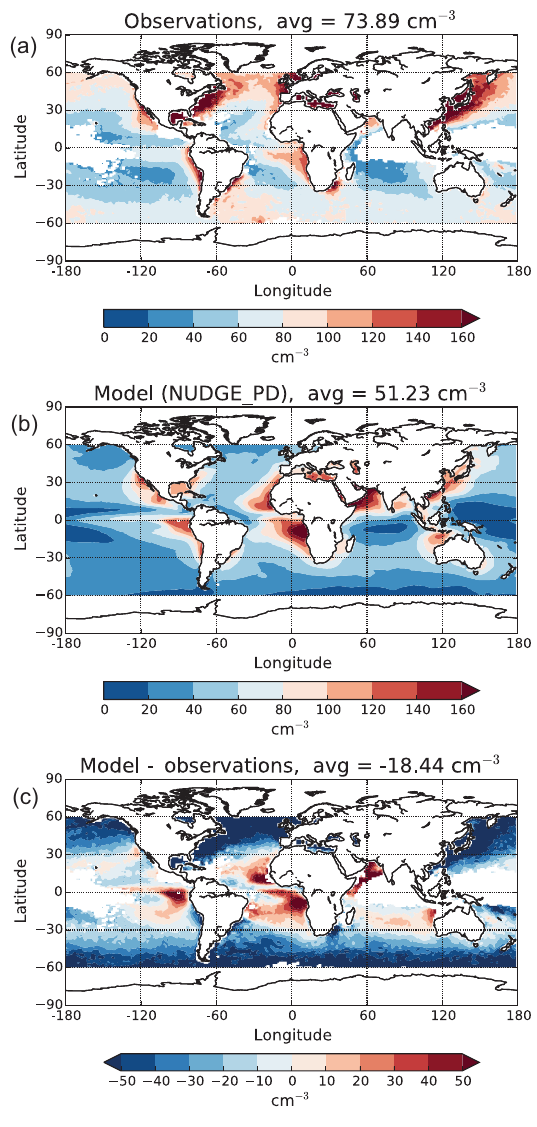
Figure 8. In-cloud cloud droplet number concentrations at cloud top in (b) CAM5.3-Oslo (NUDGE_PD) compared to (a) Bennartz and Rausch (2017), with the difference shown in (c) . White ar- eas indicate a lack of observations from MODIS meeting the cri- teria on temperature and cloud fraction given by Bennartz and Rausch